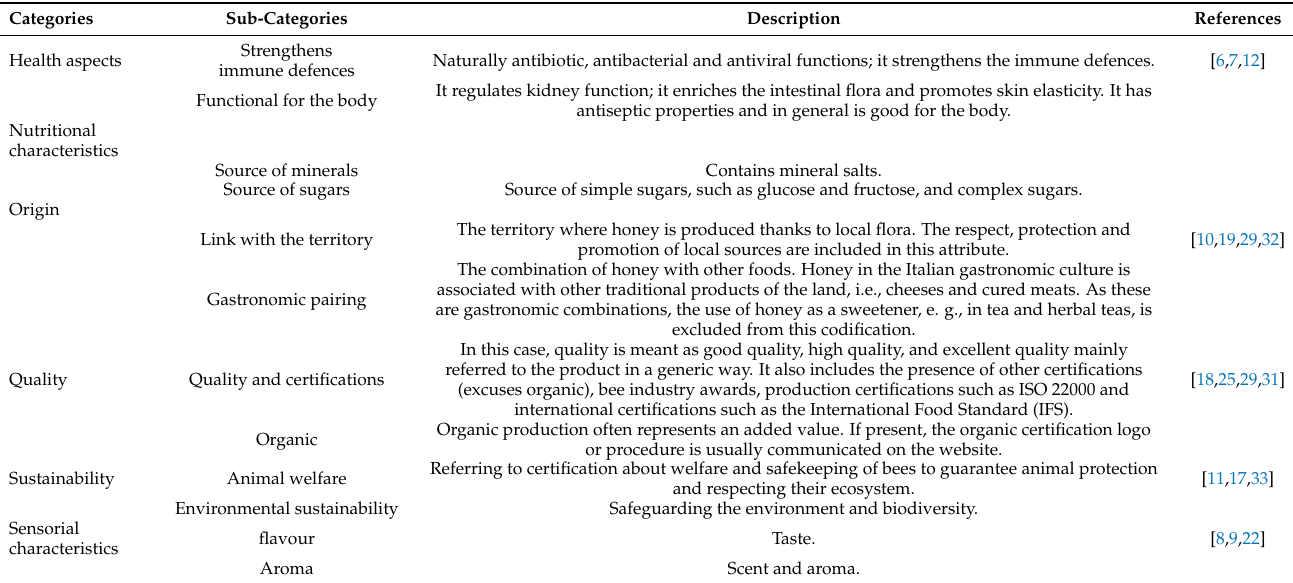
Table 2. Description of 12 attributes used to identification honey